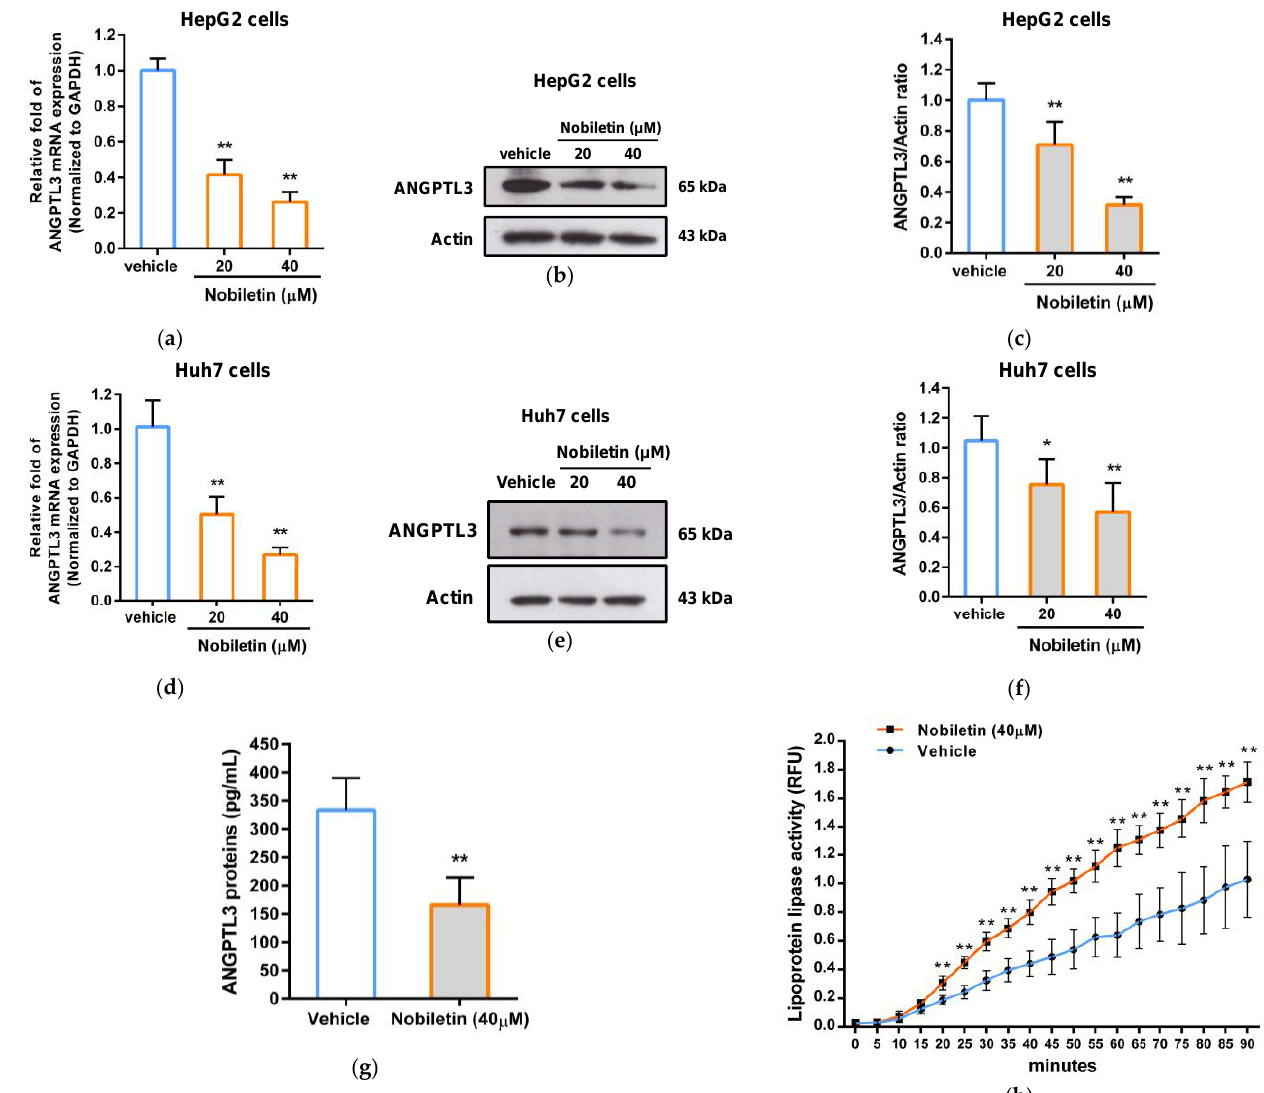
Figure 3. Effects of nobiletin on ANGPTL3 gene expression and LPL activity. HepG2 and Huh7 cells were treated with vehicle or nobiletin (20 and 40 µ M) for 24 h. ( a , d ) The mRNA levels of ANGPTL3 and GAPDH were determined using RT–qPCR. ( b , e ) The protein levels of ANGPTL3 and actin were detected via Western blotting analysis. A representative blot is shown. ( c , f ) The normalized intensity of the signal for ANGPTL3 protein versus actin protein. ( g ) The culture medium from vehicle- or nobiletin (40 µ M)-treated HepG2 cells was collected, and the extracellular ANGPTL3 protein was detected via ELISA. ( h ) The concentrated extracellular proteins (50 µ g) from vehicle- or nobiletin (40 μM) -treated HepG2 cells and LPL enzyme were incubated with substrates to determine the catalytic activity of LPL via fluorogenic analysis. The fluorescence intensity was measured over 90 min. The data represent the mean ± SD of three independent experiments. * p < 0.05 and ** p < 0.01 indicate significant differences compared to the vehicle-treated group.